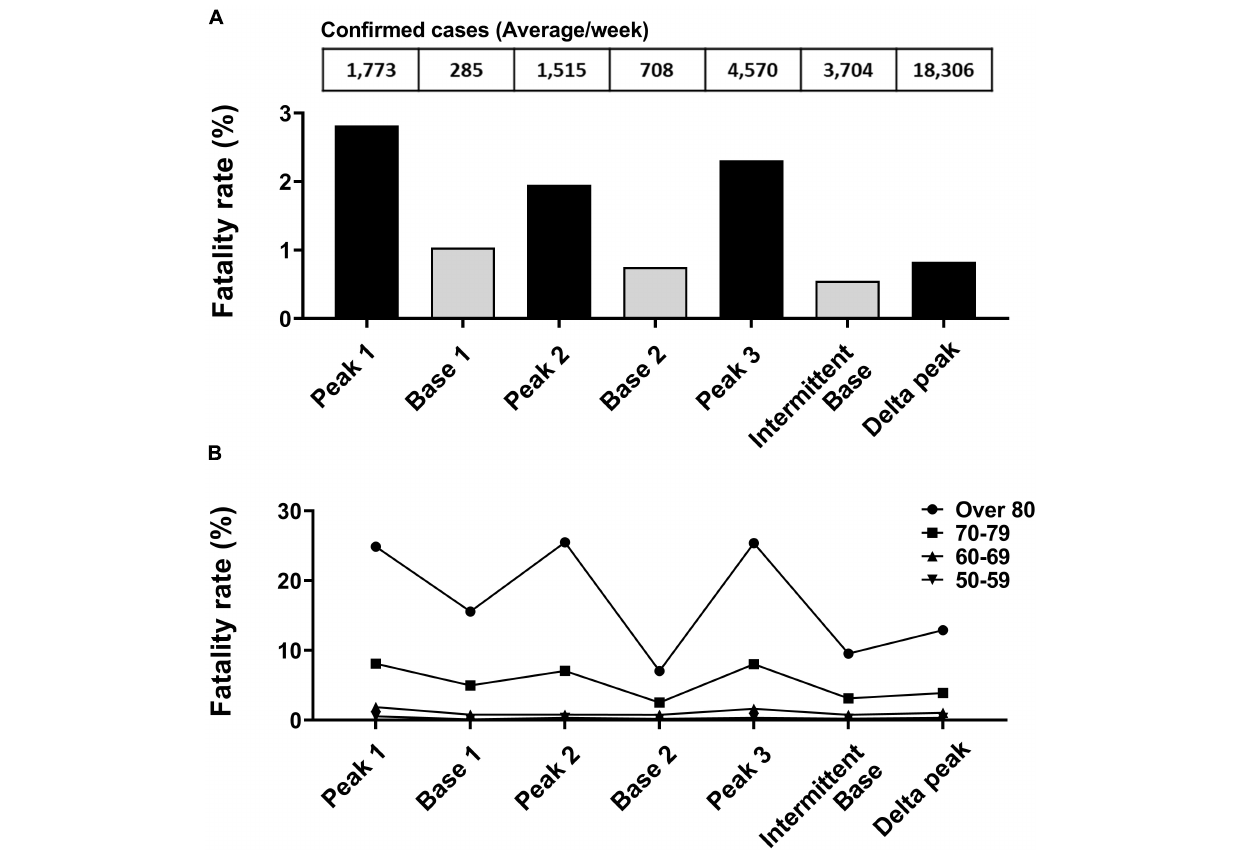
FIGURE 4 | Fatality rate analysis based on peak and base periods. (A) Deaths due to SARS-CoV-2 divided by number of confirmed cases for each specified period. (B) Fatality rate change by age group between